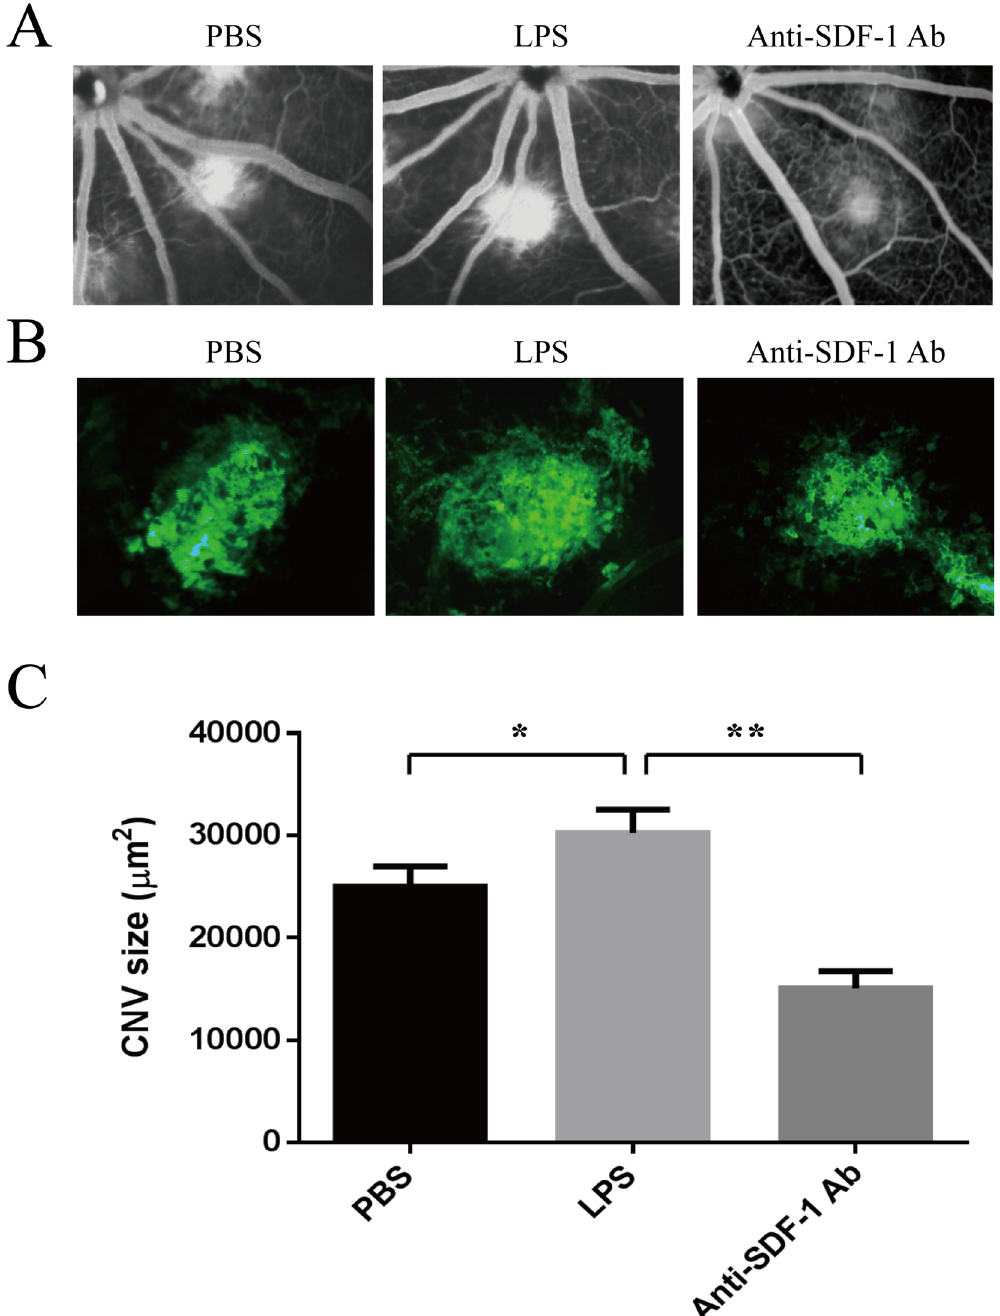
Fig 7. Effect of SDF-1 Neutralization on laser-induced CNV in LPS-treated mice. Male adult Brown Norway rats received a single intravitreal injection of 10 μ l LPS at 10 ng/ml (equivalent to an intravitreal centration of approximately 2 ng/ml) in eyes at one day before laser photocoagulation. The control rats received the same volume of vehicle (PBS). For some of LPS-treated rats, 1 μ g anti-SDF-1 antibody in a 10- μ l volume was injected immediately after laser photocoagulation. (A) Representative fluorescein angiography at 7 days after laser photocoagulation. (B) Representative images of isolectin B4 stain of RPE-choroid-sclera whole mount that performed 7 days after laser. (C) Quantitative measurement of CNV area. Data shown are mean ± SD of triplicate samples and are representative of four independent experiments. Statistical significance determined using one-way ANOVA with * P < 0.05, ** P < 0.01.